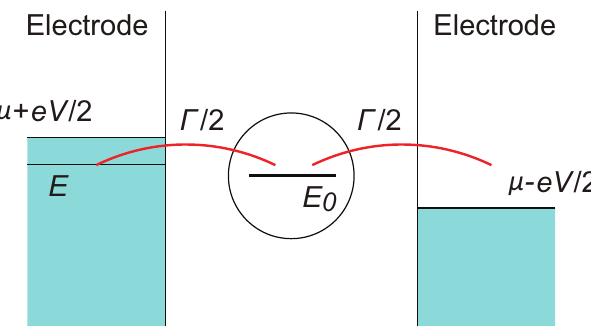
Figure 3. Schematic of the single-level model. A bridging atom is represented by a single energy level coupled with left and right electrodes. µ is the chemical potential of electrodes when the contact is in equilibrium. The bias V is time varying in the alternating current (AC) conduction of electrons. The transmission probability of an electron of energy E is given by Equation (1) in the